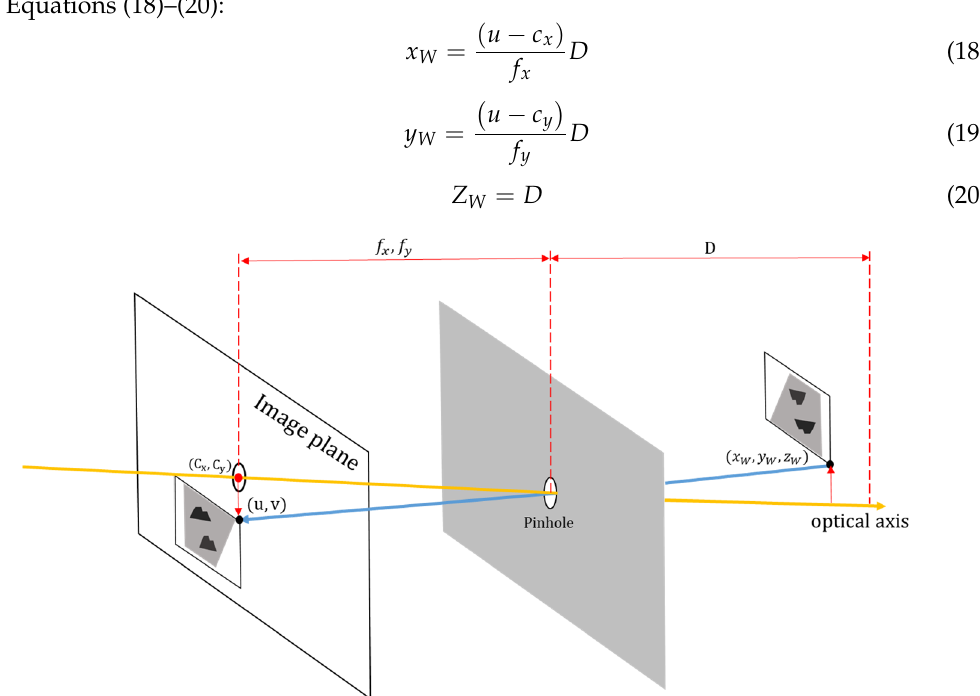
Figure 6. Pinhole camera model.